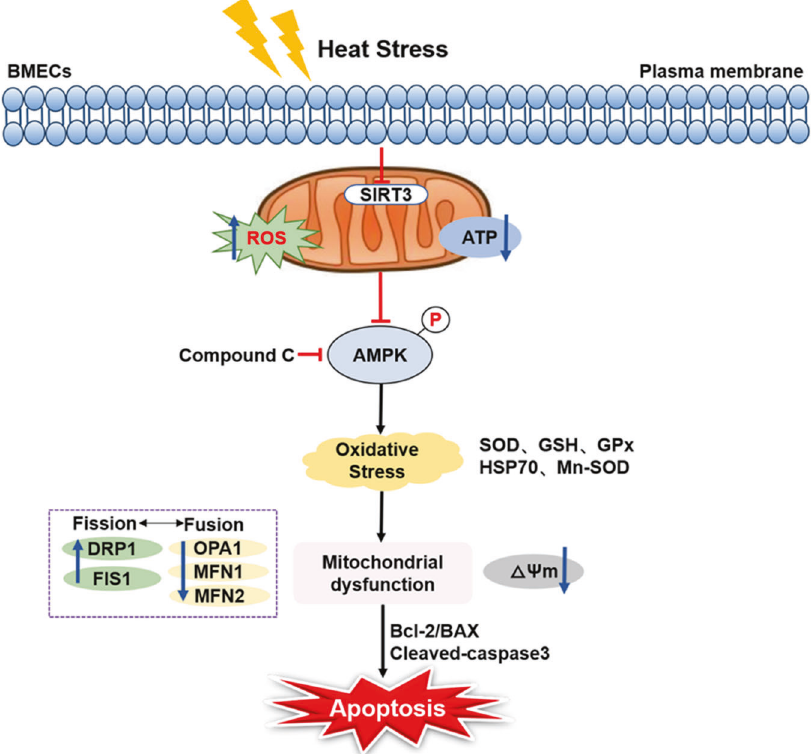
Fig. 6 The potential functional mechanism of SIRT3 in heat stress-induced BMECs. Heat stress induces low expression of SIRT3, inhibits AMPK phosphorylation, activates cell oxidative stress and mitochondrial damage, and ultimately leads to cell